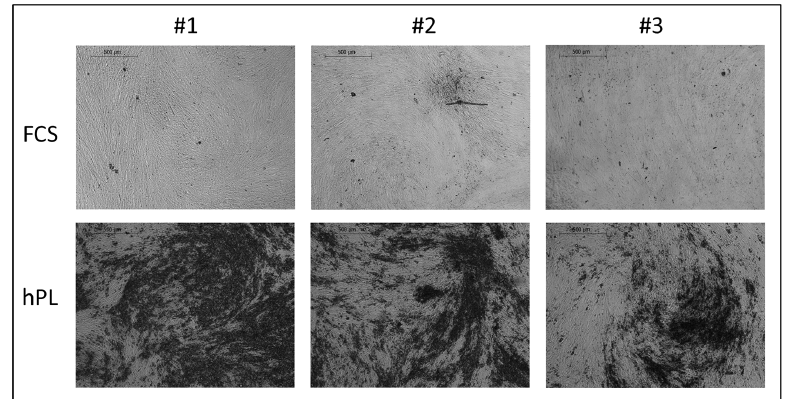
Figure 3. Detection of JPCs mineralization by von Kossa staining in Raman dishes under FCS and hPL supplementation. Microscopic images showing JPC mineralization from three donors (#1, #2, #3) cultured in Raman (glass bottom) dishes were observed after osteogenic induction for 25 days under both medium supplementations. Abbreviations: FCS—fetal calf serum, hPL—human platelet